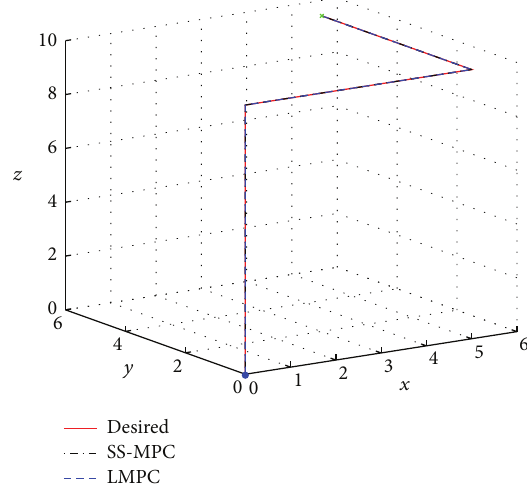
Figure 5: Tracking a 3D